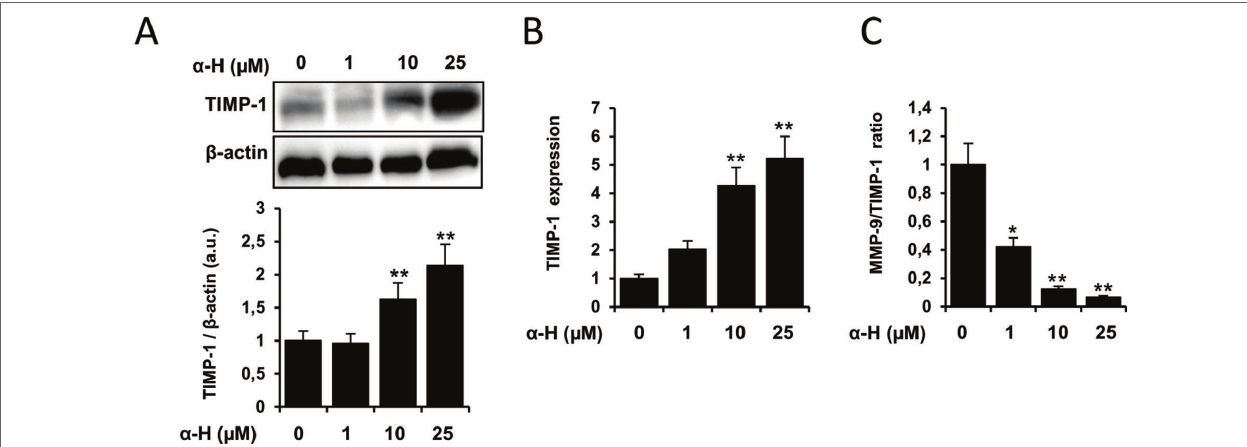
FIGURE 6 | TIMP-1 expression is upregulated after α -H treatment. U87 cells were treated with different concentrations of α -H (1, 10, and 25 μM) or vehicle as control for 24 h. (A) TIMP-1 protein levels were determined by Western blot. β -actin was used as loading control. A representative experiment is shown of three performed. Bars graphs show densitometry quantification of the bands and represent means ± S.D. from three independent experiments. (B) mRNA expression of TIMP-1 was determined by quantitative PCR. Values represent the means ± S.D. of three independent experiments performed in triplicate. (C) MMP-9/TIMP-1 ratio was calculated from data obtained by densitometry. MMP-9 data were from Figure 5B. *P < 0.05 and **P < 0.01 with respect to the non-treated